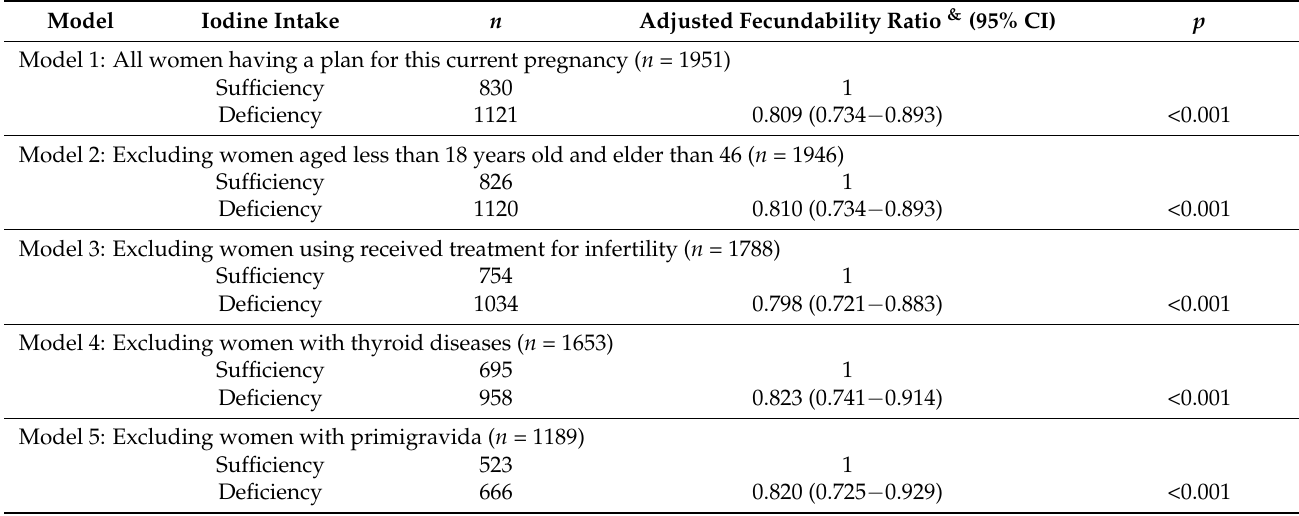
Table 2. The associations between iodine inadequacy and adjusted fecundability ratios via Cox regression analyses.